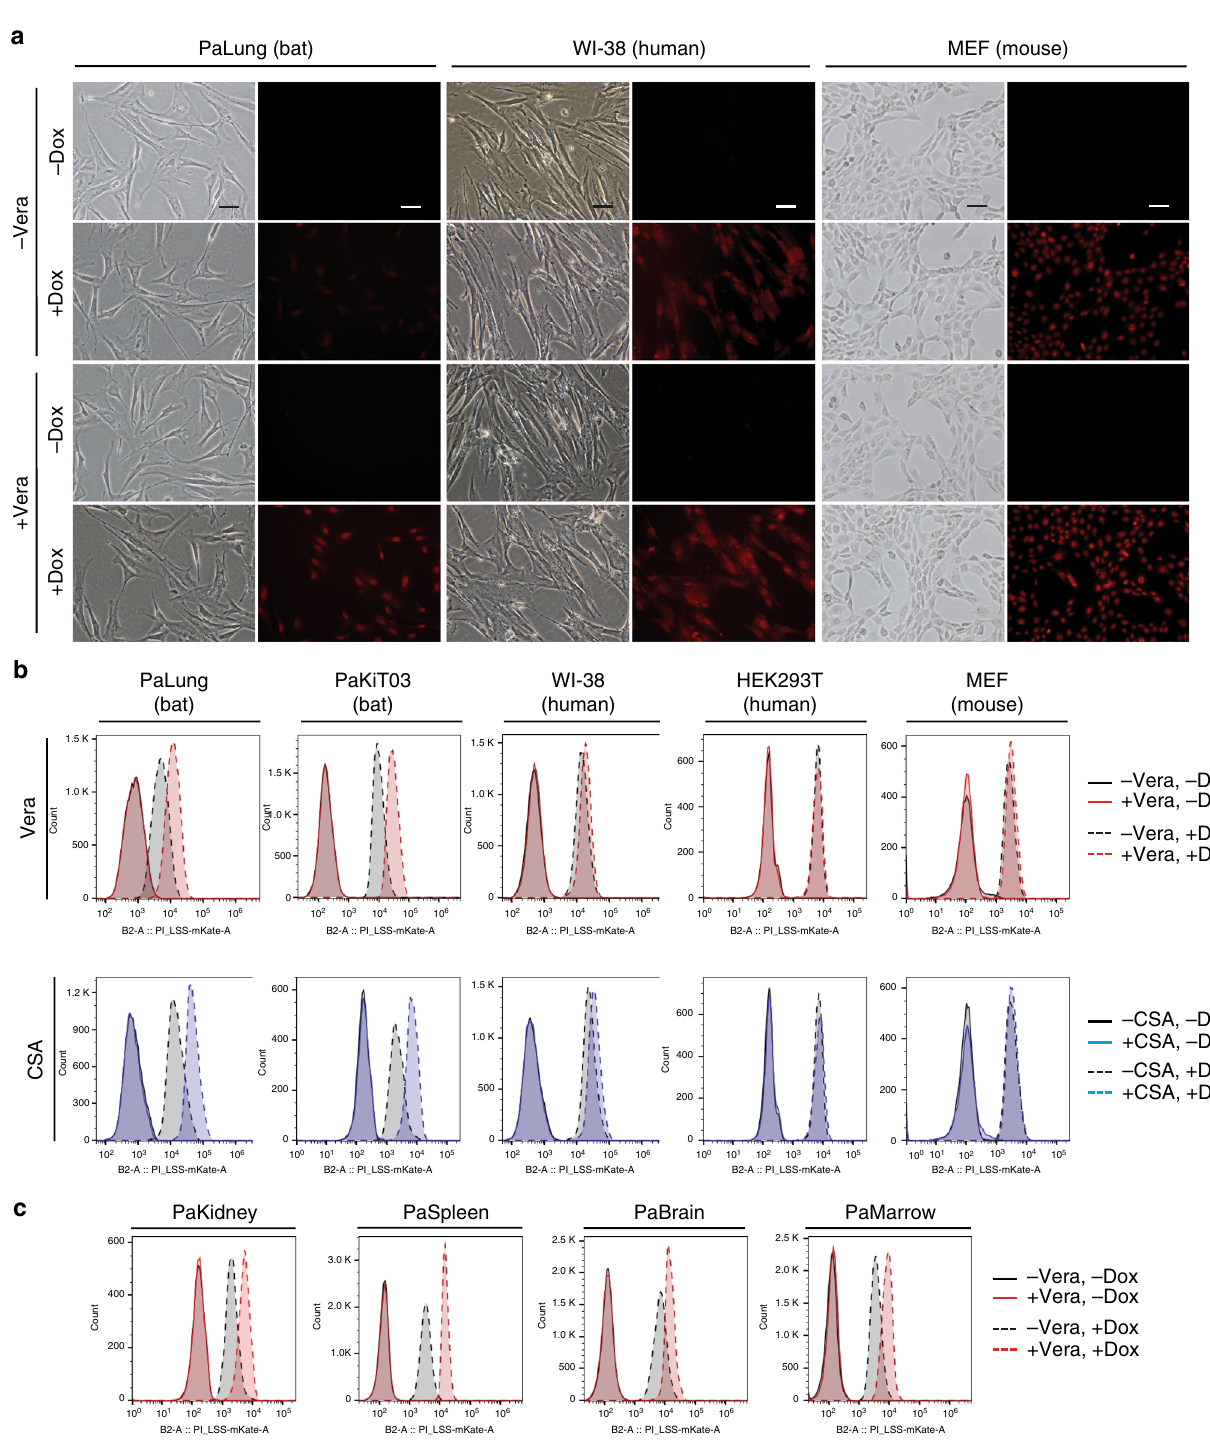
Fig. 3 Analysis of drug ef fl ux capability via ABC transporters. a Doxorubicin (Dox) fl uorescence or phase contrast images of PaLung, WI-38, and MEF cells. Cells were pre-treated without or with 5 μ M verapamil (Vera) for 30 min before the treatment with 10 μ M doxorubicin alone or together with Vera for an additional 3 h. Images were acquired with 20× objective lens, and scale bar represents 50 μ m. b Flow cytometry analyses of Dox accumulation in PaLung, PaKiT03, WI-38, HEK293T, and MEF cells. Cells were pre-treated without or with 5 μ M verapamil (Vera, top row) or 5 μ M cyclosporin A (CSA, bottom row) for 30 min before the treatment with 10 μ M doxorubicin alone or together with Vera or CSA for an additional 3 h. c Flow cytometry analyses of Dox accumulation in cells derived from different tissues of P. alecto in the presence or absence of verapamil. Cells were treated and analysed as in ( b ). All results shown are representative of at least three experimental